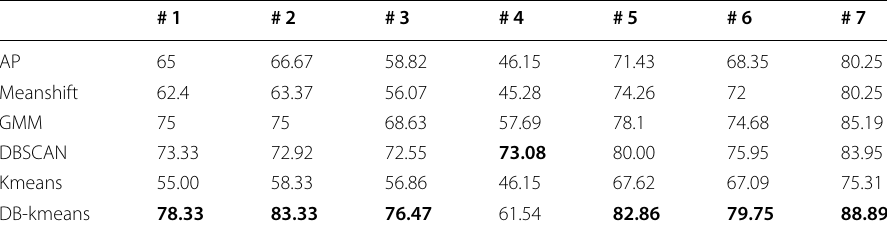
Bold values are the results of the method proposed in this paper